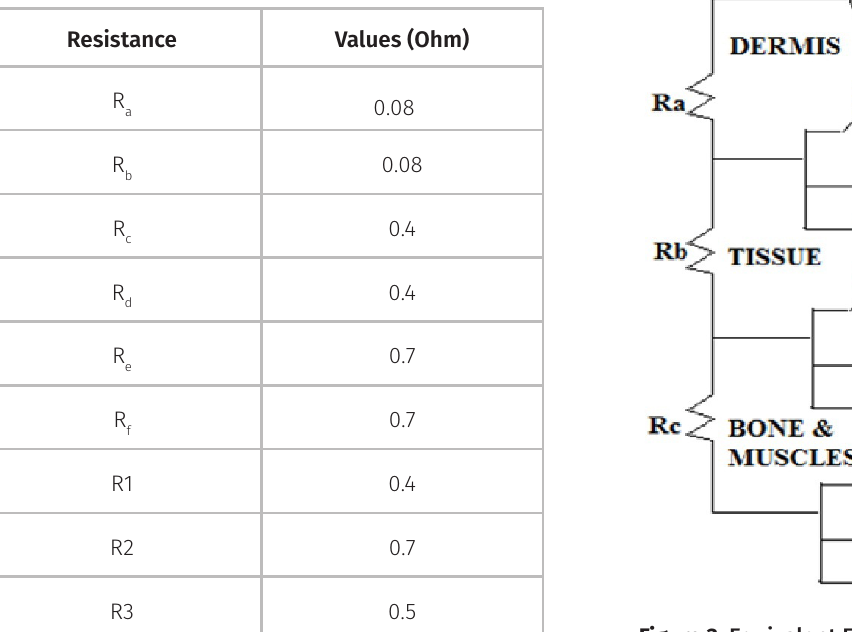
Figure 3. Equivalent Electrical System of skin.